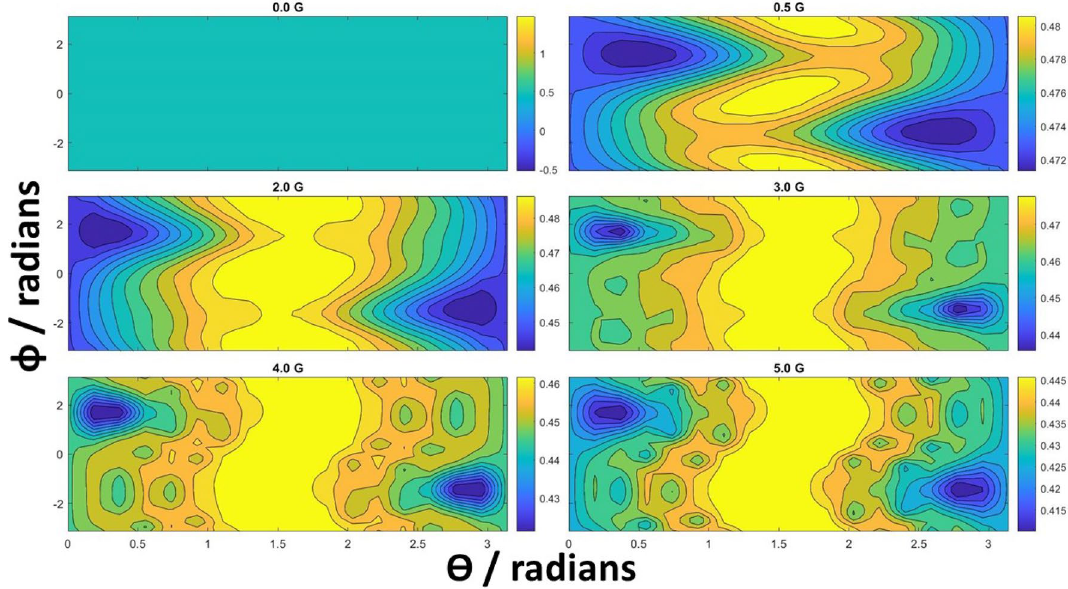
Figure 5. Signalling yield as a function of external magnetic field in the radical pair model with solid arrows � B = ( B in Fig. 4. The field is parameterised in spherical coordinates 0 sin θ cos φ , B 0 sin θ sin φ , B 0 cos θ) , with the photolyase molecular axis lying along the z-axis. The evolution in the magnetic field is governed by the Hamiltonian given in Eq. (3), using the hyperfine tensors measured via EPR and ENDOR techniques 44,50 ,